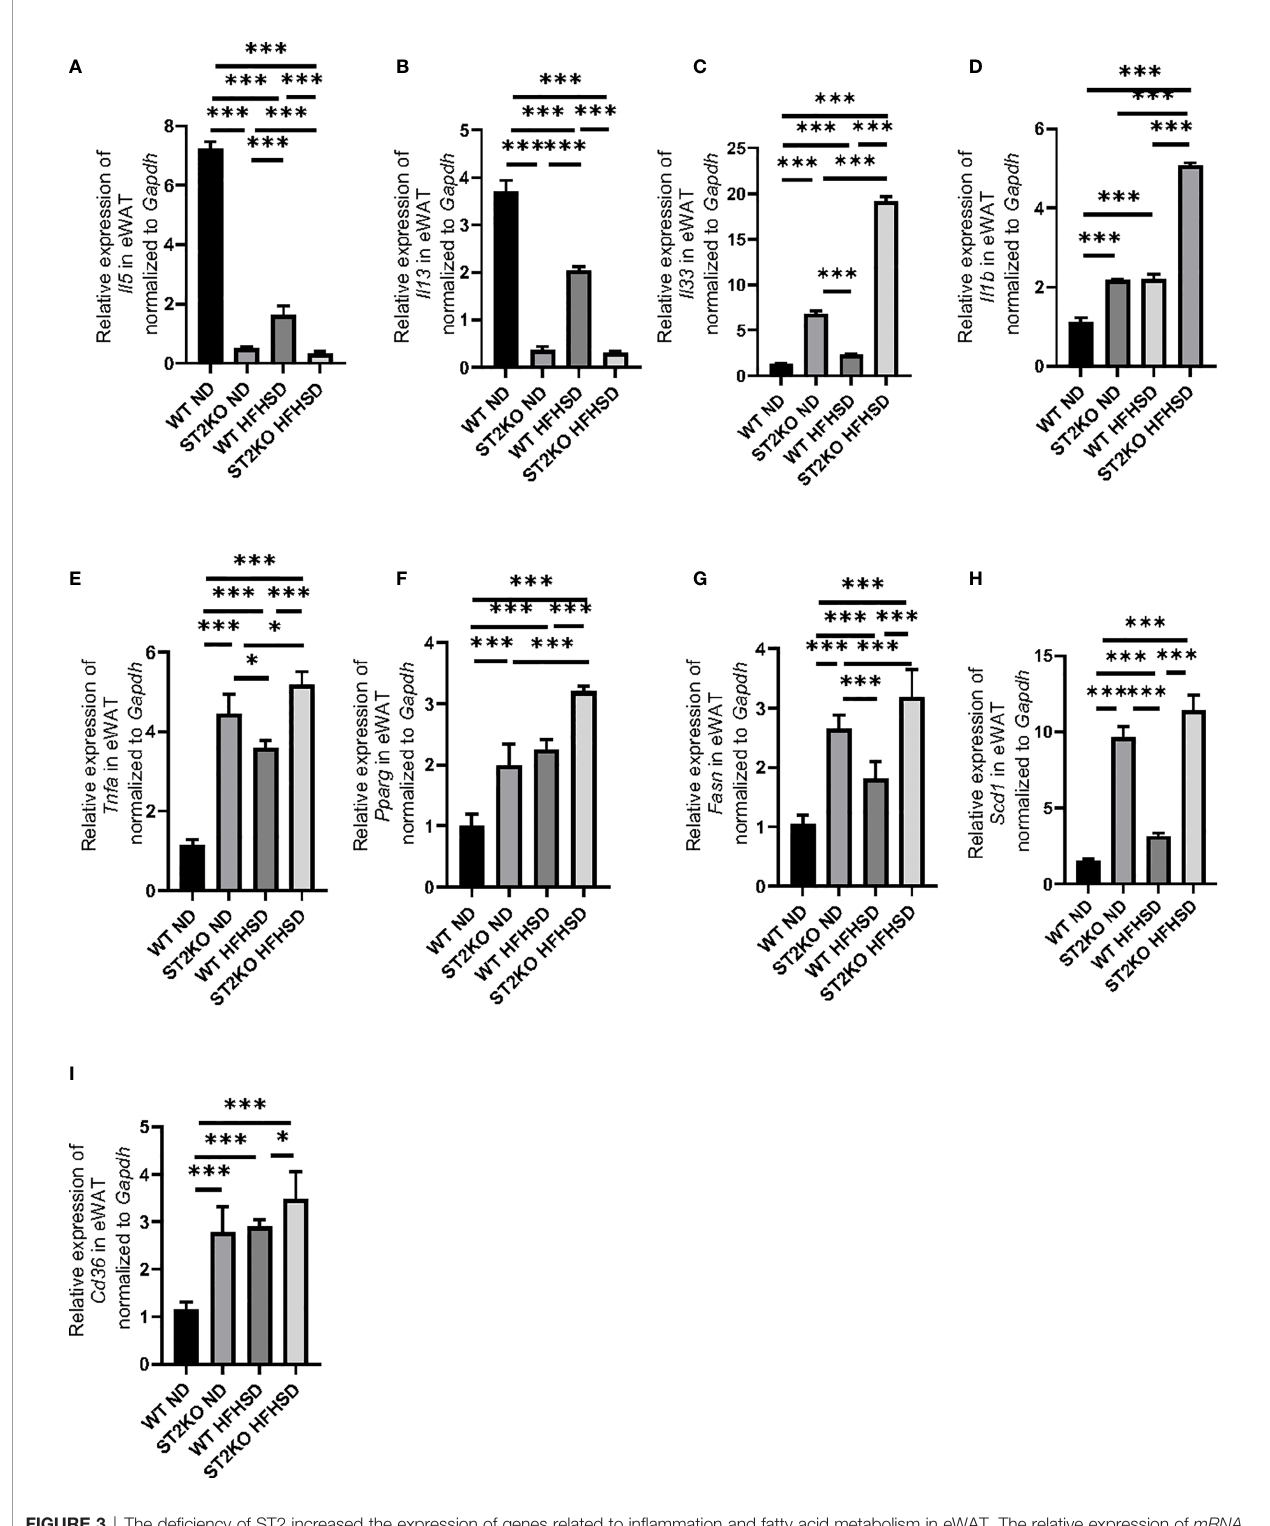
FIGURE 3 | The de fi ciency of ST2 increased the expression of genes related to in fl ammation and fatty acid metabolism in eWAT. The relative expression of mRNA (A) Il5 , (B) Il13 , (C) Il33 , (D) Il1b , (E) Tnfa , (F) Pparg , (G) Fasn , (H) Scd1 , and (I) Cd36 of indicated genes in epididymal white adipose tissue (eWAT) normalized to Gapdh (n = 6). Data are represented as mean±SD; *p < 0.05, ***p < 0.001 by One-way ANOVA